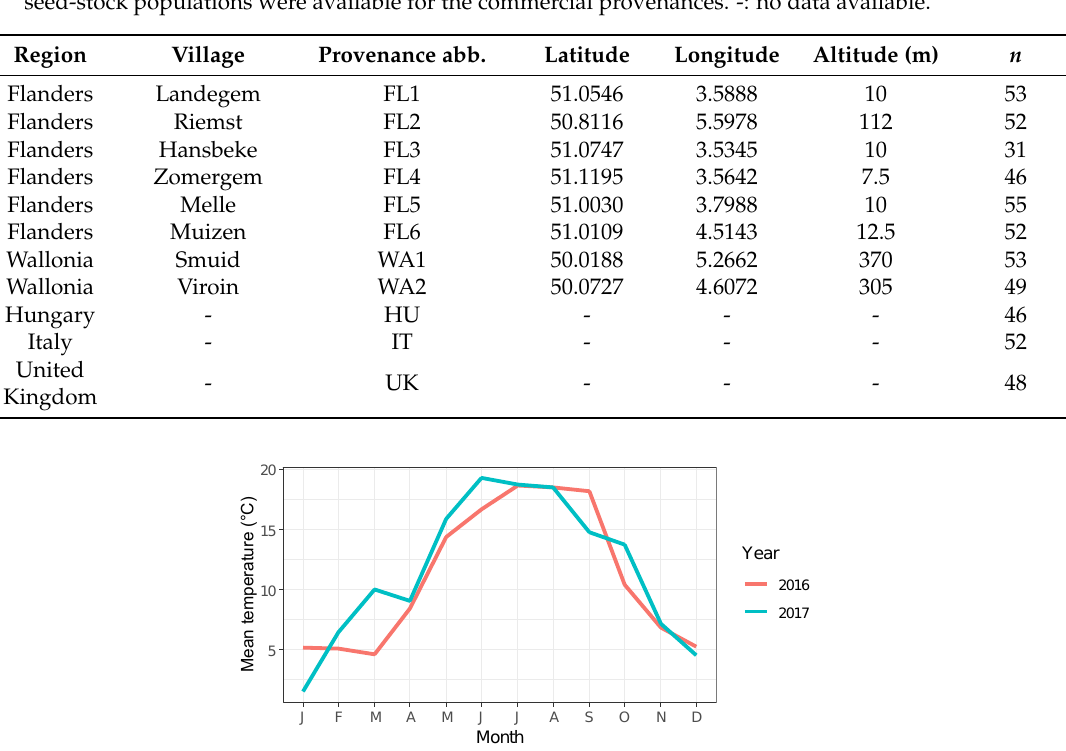
Figure 1. Mean monthly temperatures in 2016 and 2017 in Groenendaal, Belgium.